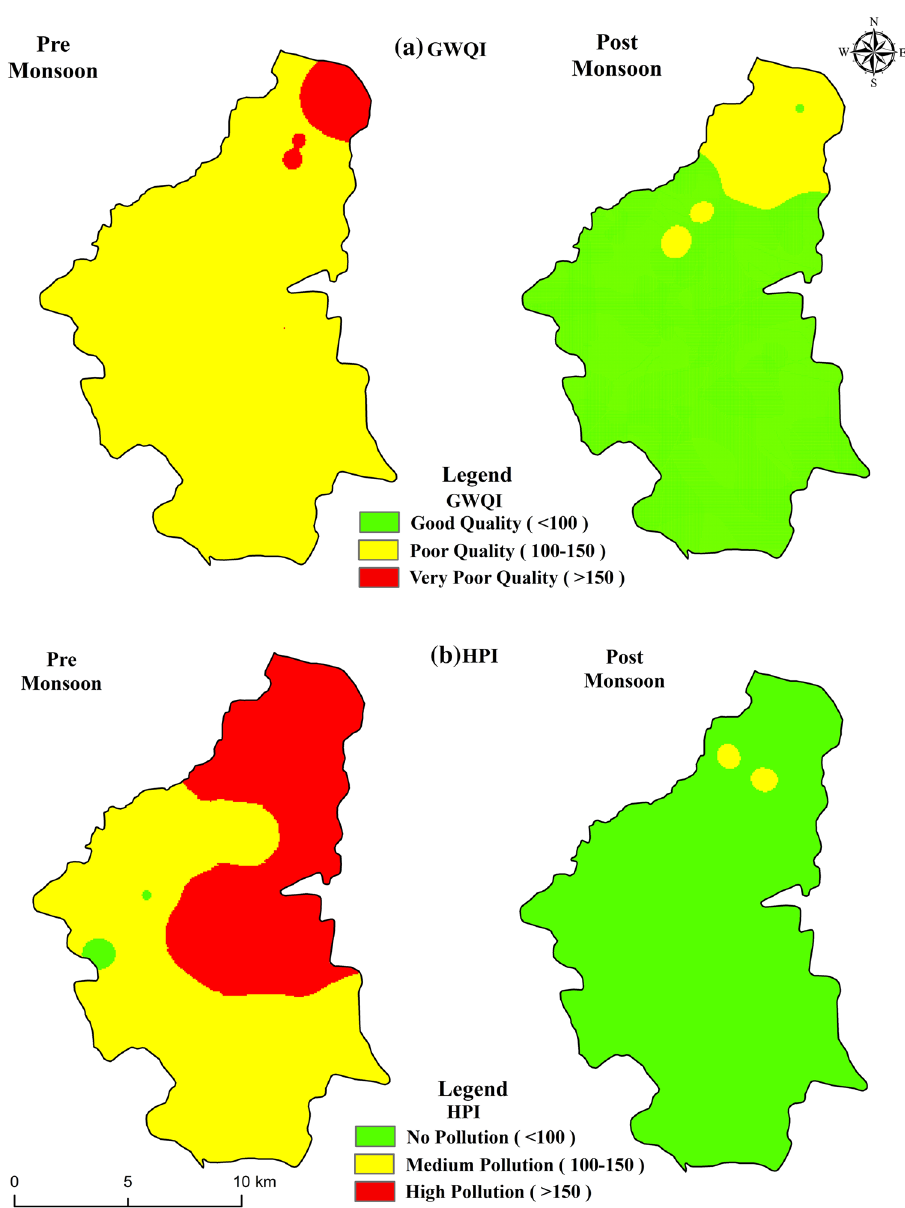
Fig. 2 Spatial distribution of groundwater quality (GWQ) and Heavy metal